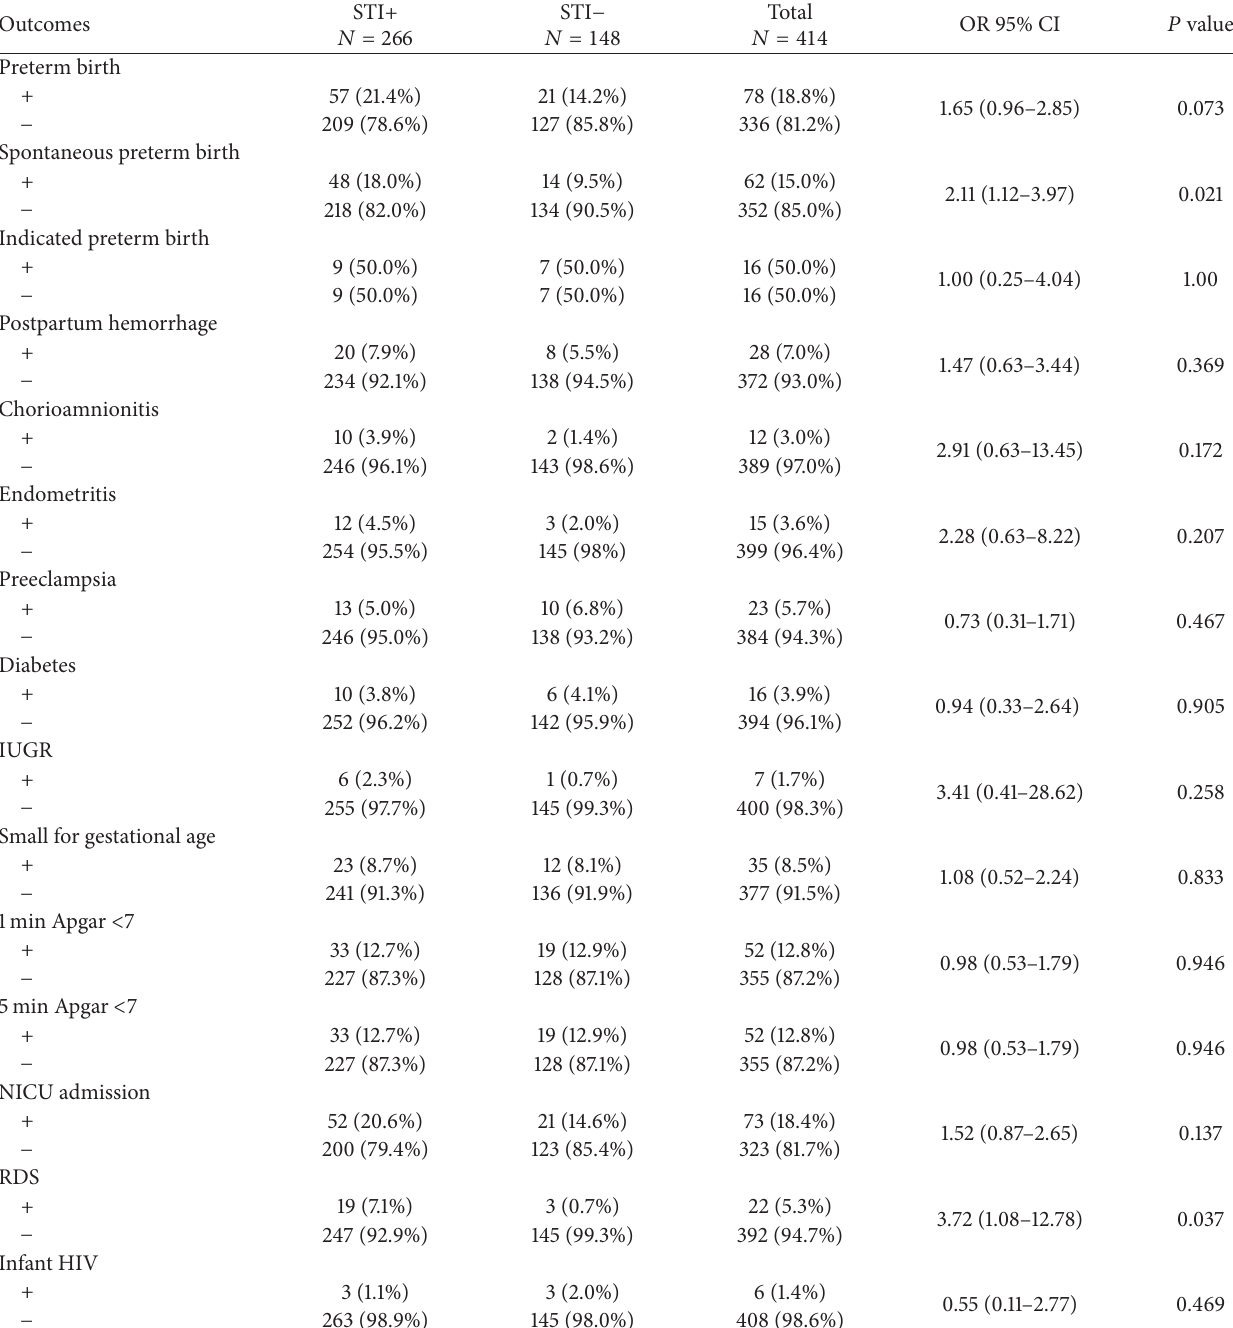
Table 3: Perinatal and neonatal outcomes in HIV+ women with and without concomitant sexually transmitted infections.